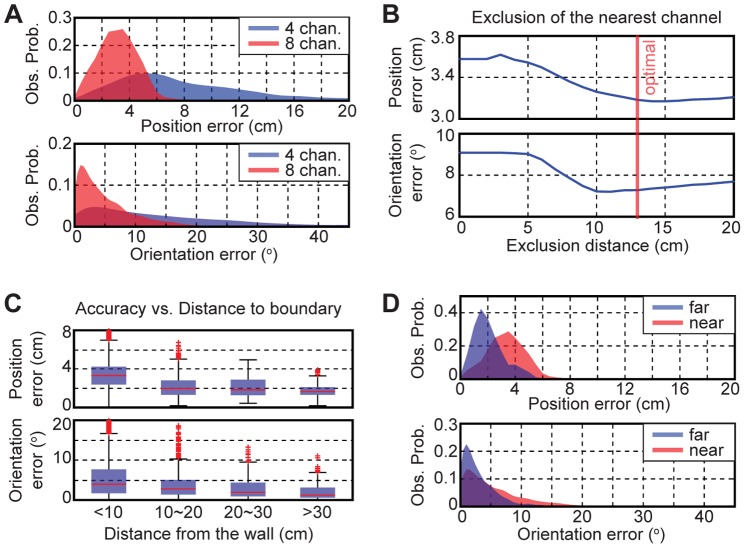
Single fish tracking accuracy.
A) The error distribution of the dipole tracking for the four (blue) and eight (red) channel configurations (Obs. Prob.: Observation probability). B) The tracking accuracy improved after excluding the channel nearest to the fish within a set exclusion distance. C) The tracking errors were plotted vs. the distance from the tank wall. On each box, the central mark (red line) is the median, the edges of the box are the 25th and 75th percentiles, and the whiskers extend to the most extreme data points not considered outliers. Outliers are plotted individually (red markers): a value that is more than 1.5 times the interquartile range away from the top or bottom of the box as determined using the boxplot function (Statistics toolbox for Matlab). D) The error distributions of the dipole tracking near (<10 cm, red) and far (>10 cm, blue) from the tank wall.